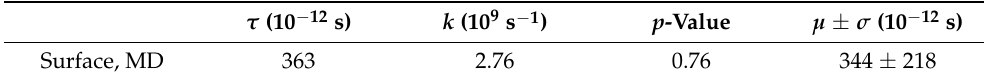
Table 1. Drug release time ( τ ) and rate ( k = 1/ τ ). p -value measures the quality of the fit using the Kolmogorov–Smirnov analysis. We also present the average release time µ and its standard deviation σ .